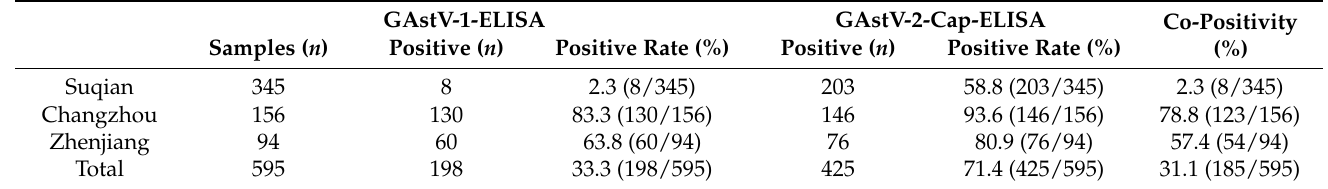
Table 4. GAstVs antibody detection results by the established ELISAs from 595 serum